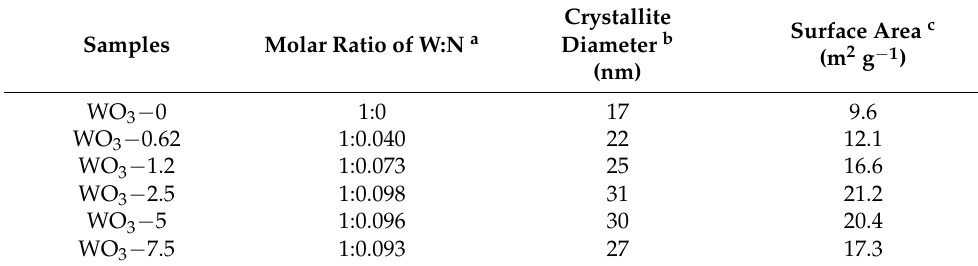
Table 1. Summary of physicochemical properties of different WO 3 samples.